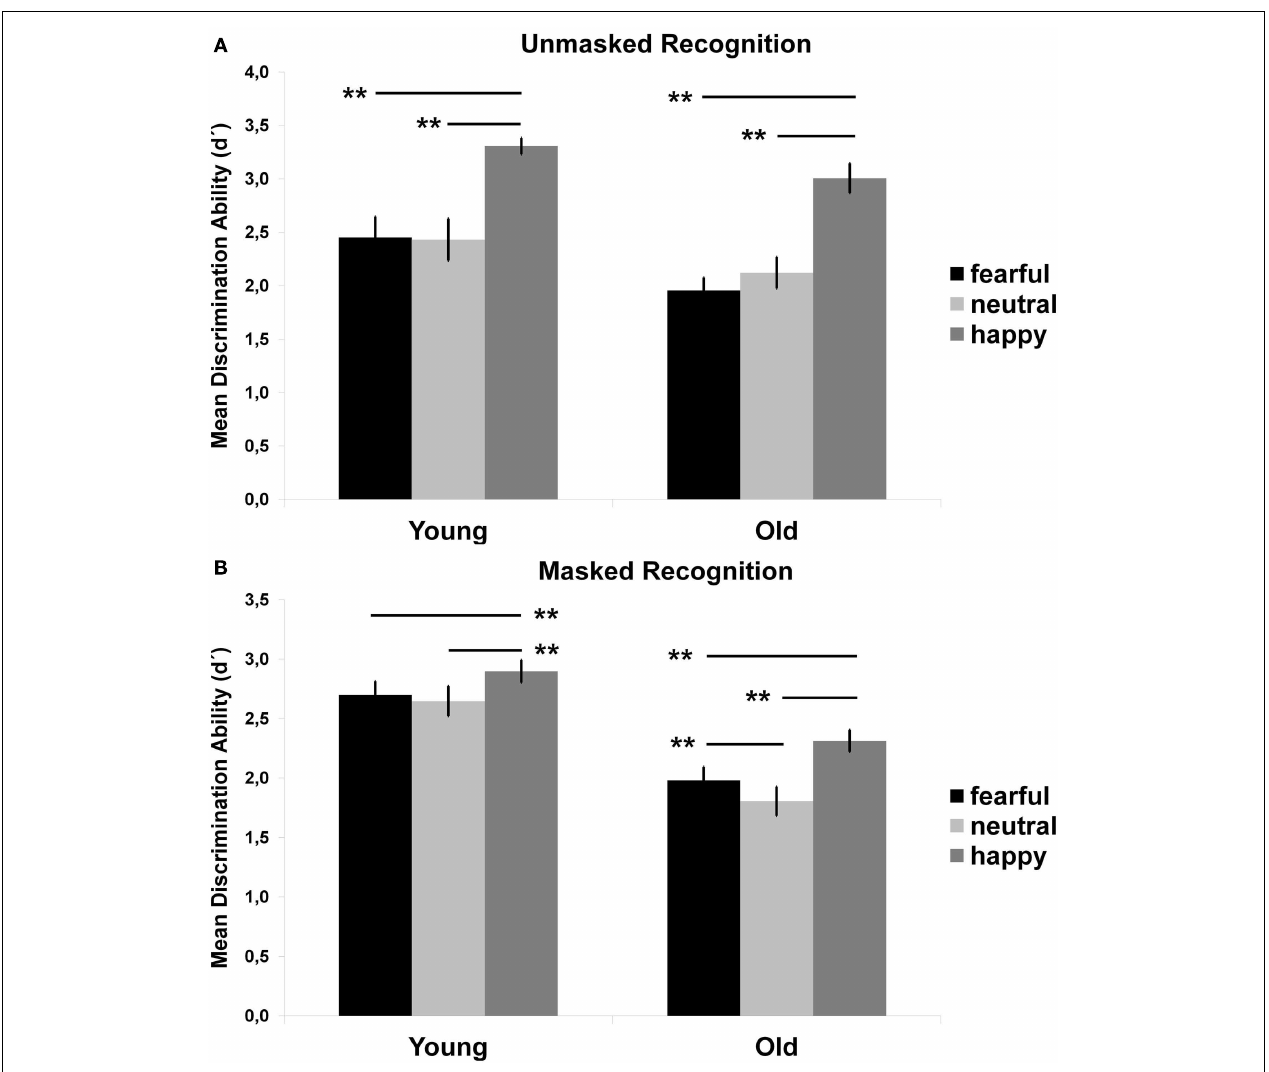
FIGURE 2 | Mean (SE) recognition performance ( d (cid:48) ) across durations in the unmasked recognition task (A) and masked recognition task (B), separately for expression and age. Note. Results of t -tests for age differences are denoted with asterisks. ** p < 0.01, * p < 0.05.